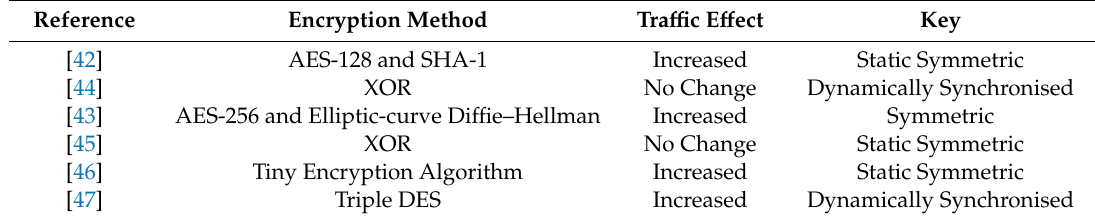
Table 3. Encryption methods for the CAN